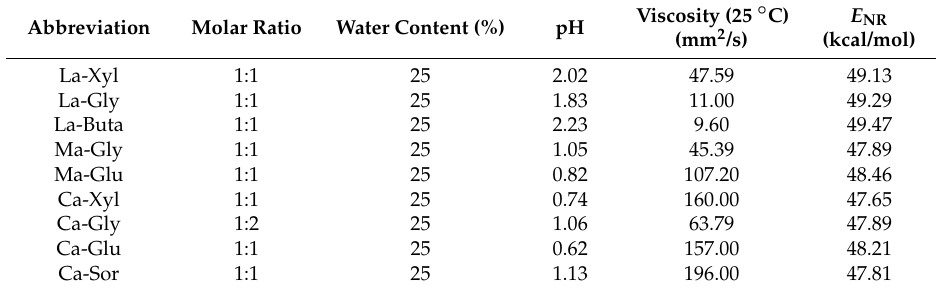
Table 3. Abbreviations and properties of 75% organic acid-based DES solutions tested for